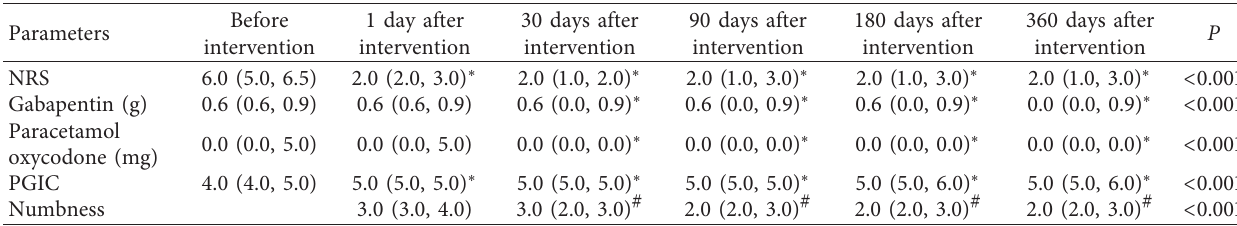
Table 2: Comparison of NRS, gabapentin (g), paracetamol oxycodone (mg), PGIC, and numbness before and after PRF (median (P